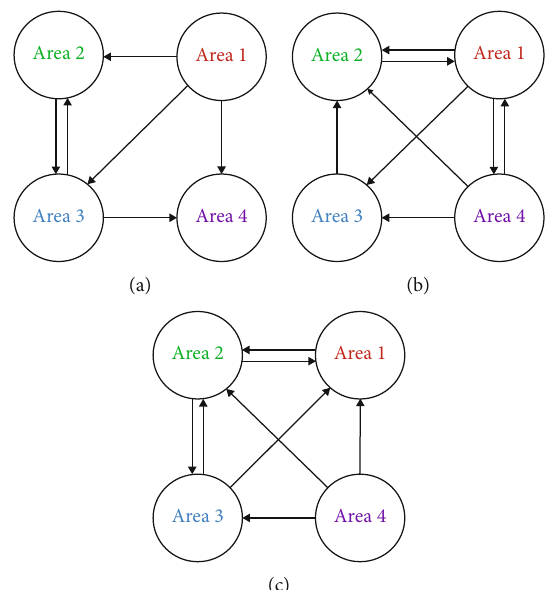
Figure 8: The causal connectivity of the features extracted by the proposed model under the three conditions: (a) the awake condition; (b) the fatigue condition; (c) the sleep deprivation condition. The connection between areas is signi fi cant ( P < 0 : 01 ).